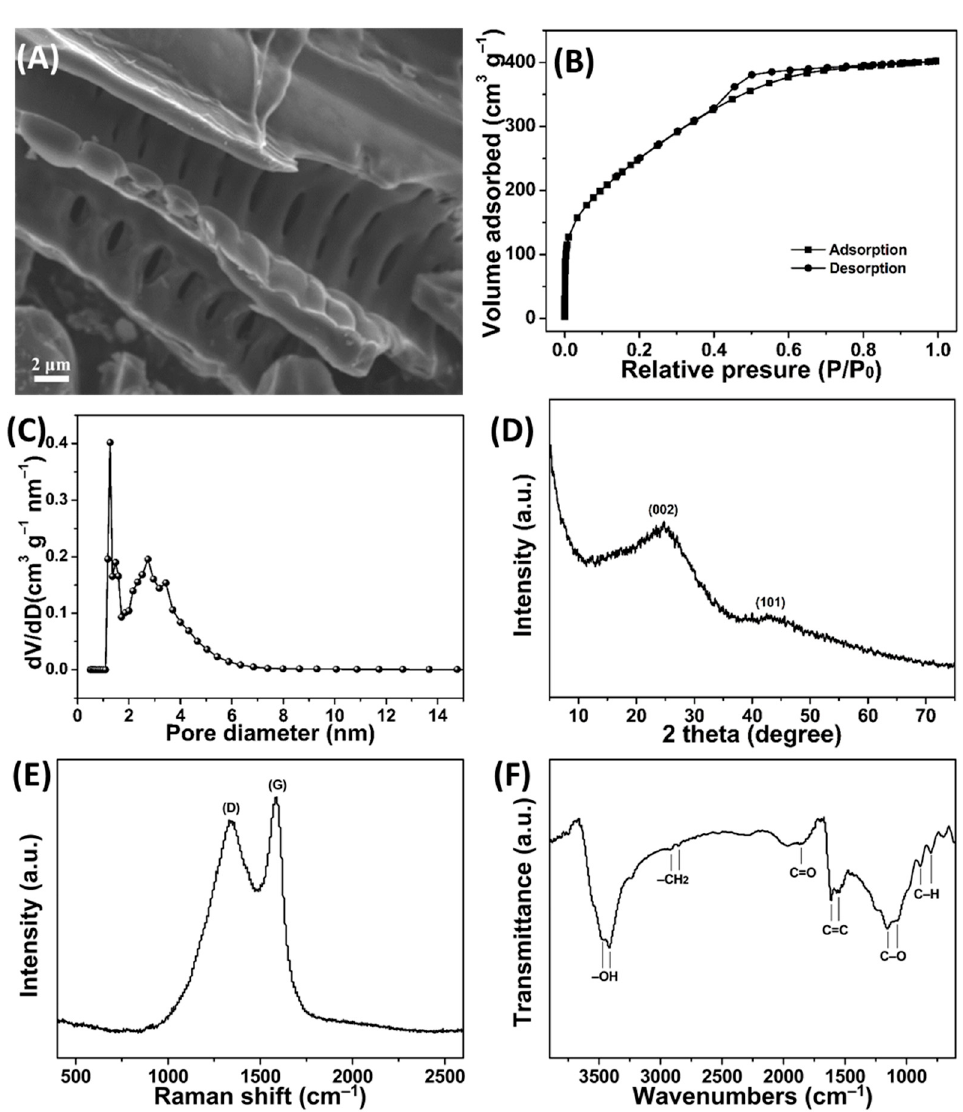
Figure 3. ( A ) SEM image, ( B ) nitrogen adsorption–desorption isotherm, ( C ) pore size distribution, ( D ) XRD pattern, ( E ) Raman, and ( F ) FTIR spectra of PPPC. ( D ) XRD pattern, ( E ) Raman, and ( F ) FTIR spectra of